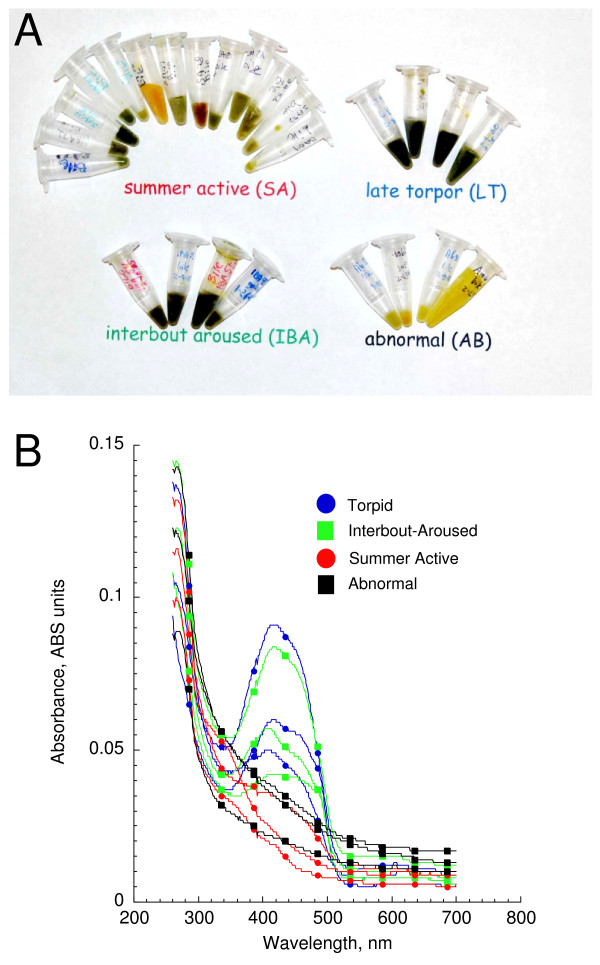
Gallbladder bile color varies by season and hibernation. A) Photograph of bile collected from golden-mantled ground squirrels (Spermophilus lateralis) as a function of state. Bile was collected from squirrels collected monthly (2–3 squirrels per month) from May (left) until September (right; summer active, SA), squirrels during winter that were torpid (T) when body temperature was ~5°C, squirrels during the euthermic period between bouts of torpor (interbout-aroused; IBA), and squirrels that were sampled in winter but had failed to hibernate (abnormal, AB). As an indication of approximate volumes, microcentrifuge tubes contain all of the collected bile for each animal except one AB animal (full tube on lower right; ~2.5 ml of bile was collected from that animal). B) Spectral characteristics of bile as a function of state. Each line represents one animal. Data are depicted for 3 animals of each state and only every 50th symbol is plotted for clarity.